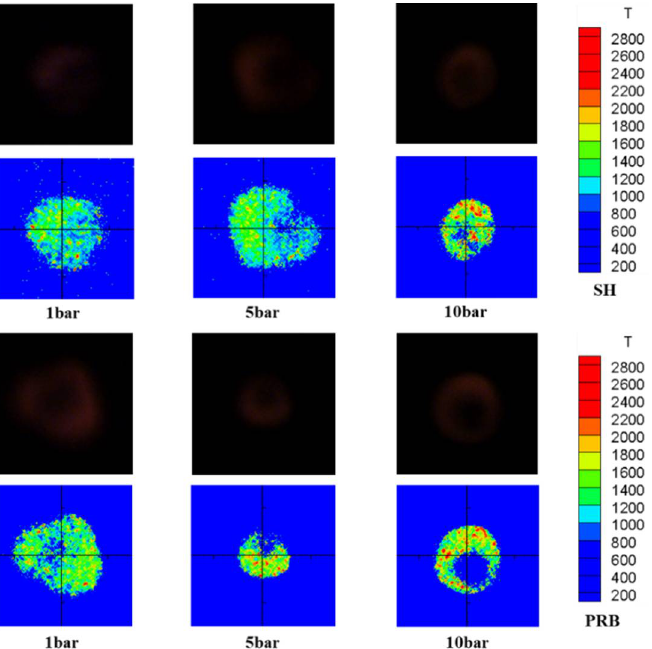
Figure 12. The transient temperature distribution of SH bituminous coal and PRB sub-bituminous coal volatile combustion under different pressures.